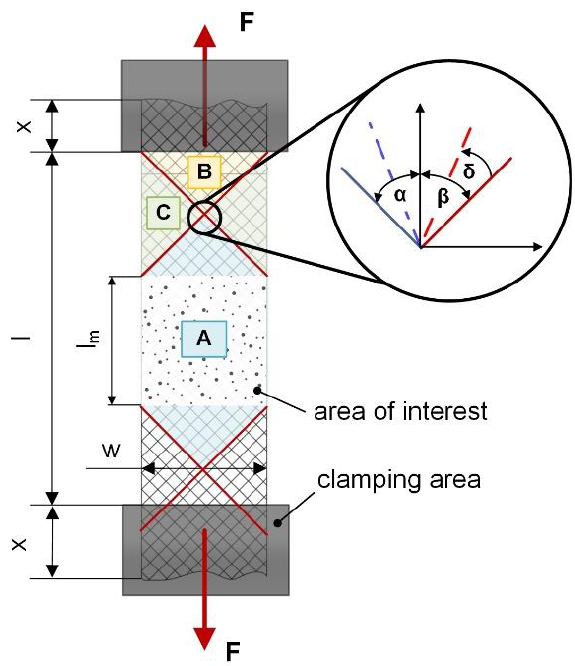
Figure 2. The three main shear zones (A, B and C) corresponding to the exemplary ±45° fiber orientation in a composite tensile test configuration [44] and the explanation of the in-plane shearing effect with the shear angel δ on undistorted (blue and red line) and distorted (dashed blue and red line) fibers [47].